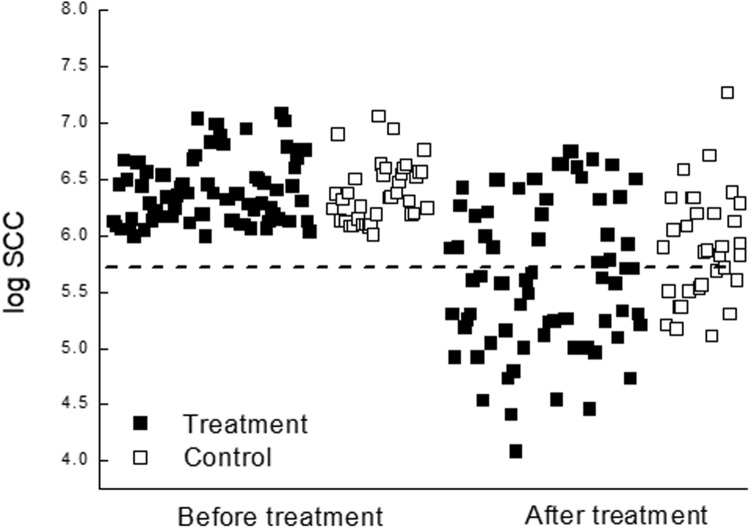
Distribution of somatic cell count.Distribution of individual logSCC of 116 cows from 3 commercial herds identified with subclinical mastitis, before treatment and up to 3 months after it, according to Acoustic pulse therapy (APT) treatment (■; n = 78) and control (□; n = 38).